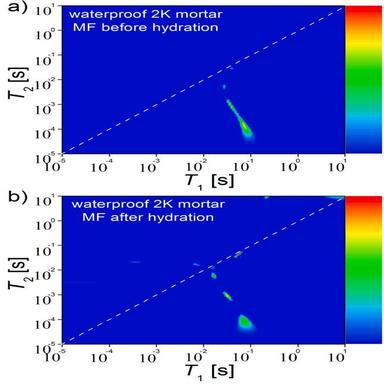
Two-dimensional T1-T2 correlation maps measured for MF mortar: a) before hydration and b) after hydration.